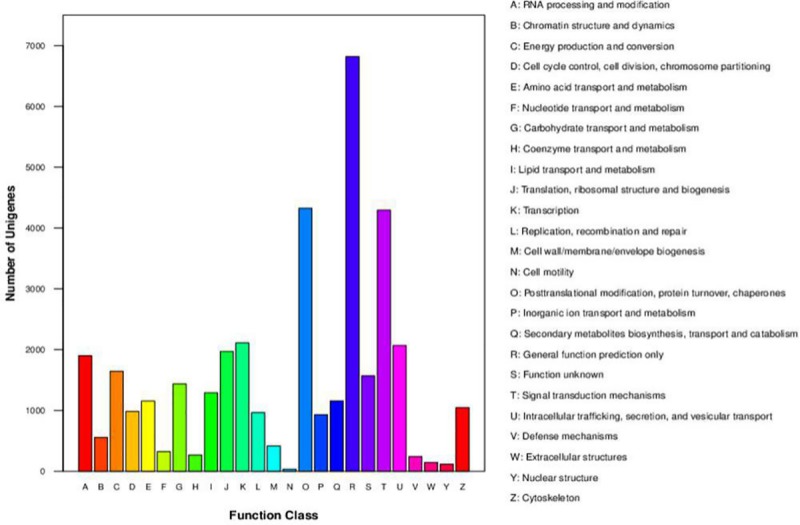
KOG fuction classification.The X-axis shows the functional classes of KOG, and the Y-axis shows the numbers of unigenes in every class.